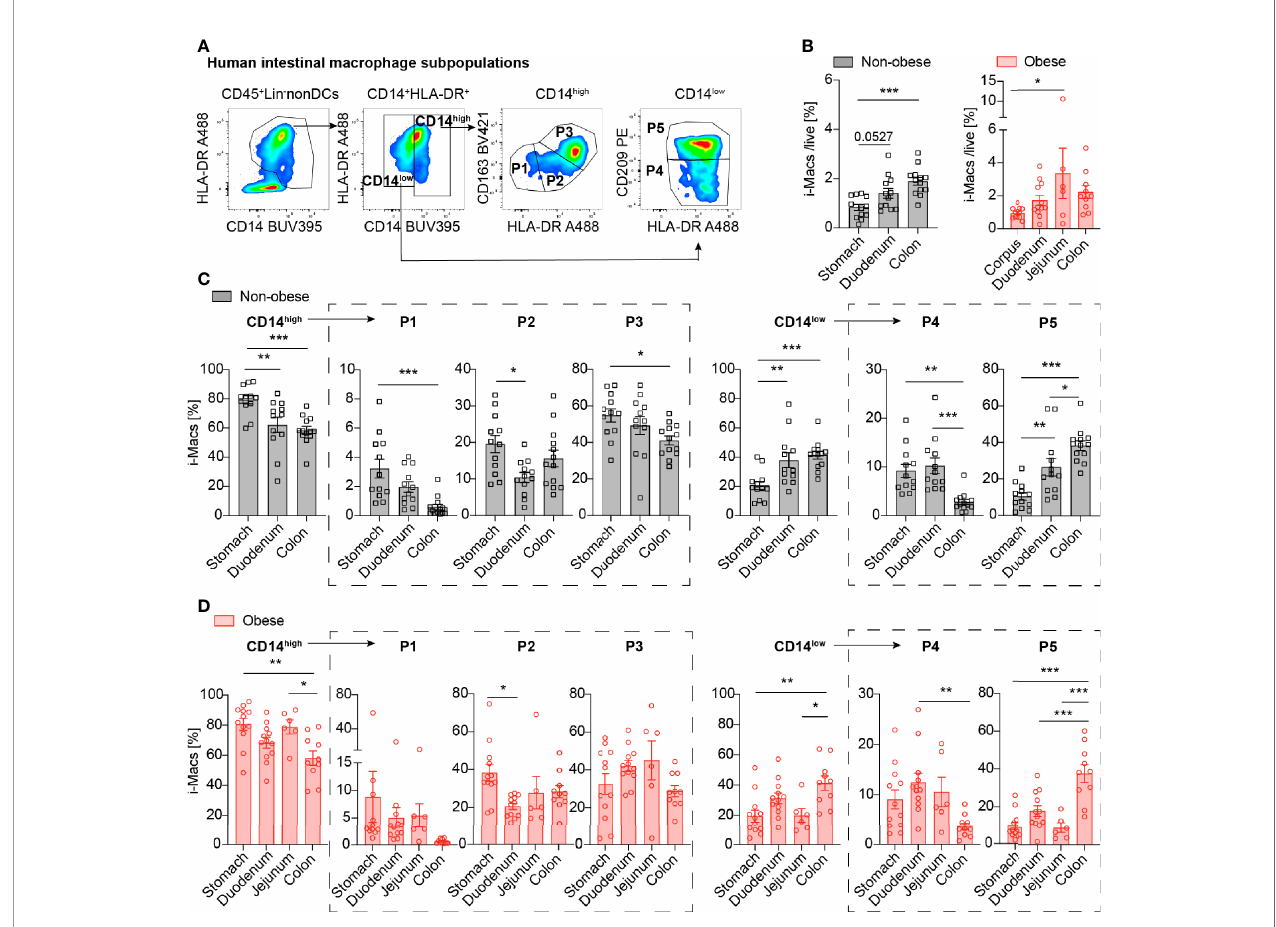
FIGURE 2 | Intestinal macrophages increase along the gastrointestinal tract, particularly the anti-in fl ammatory/resident subpopulation P5. (A) Flow cytometry gating strategy of human intestinal macrophages (CD14 high (pro-in fl ammatory P1, P2 and intermediate P3) and CD14 low (anti-in fl ammatory/resident P4, P5 subpopulations). (B) Frequency of total intestinal macrophages in non-obese (BMI <27 kg/m 2 ) and obese subjects (BMI >32 kg/m 2 ) in the stomach, duodenum, and colon (n=12-13). (C, D) Distribution of intestinal macrophage subpopulations in non-obese (C) or obese subjects (D) in the stomach, duodenum, jejunum, and colon (n = 10-12). One data point represents one subject. Statistical data are expressed as mean ± SEM. * p <0.05. ** p <0.01, *** p <0.001, tested by ordinary one-way